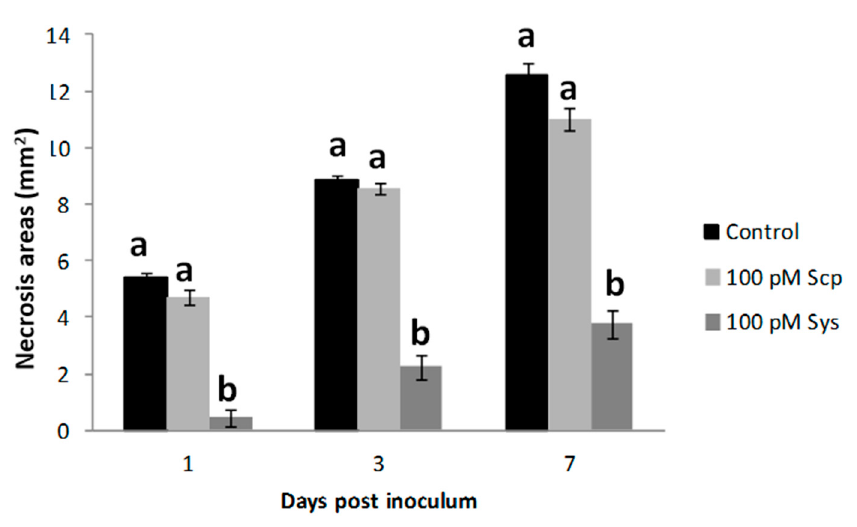
Figure 5. Enhanced resistance to Botrytis cinerea of tomato plants supplied with systemin via hydroponics. Response to B. cinerea infection by leaves from plants treated with 100 pM Sys, or 100 pM Scp or PBS1X in hydroponics. The graphs display the average (± S.D.) of the lesion size at 1, 3 and 7 days post inoculum. Letters denote statistically significant differences (One-way ANOVA, Tukey test).